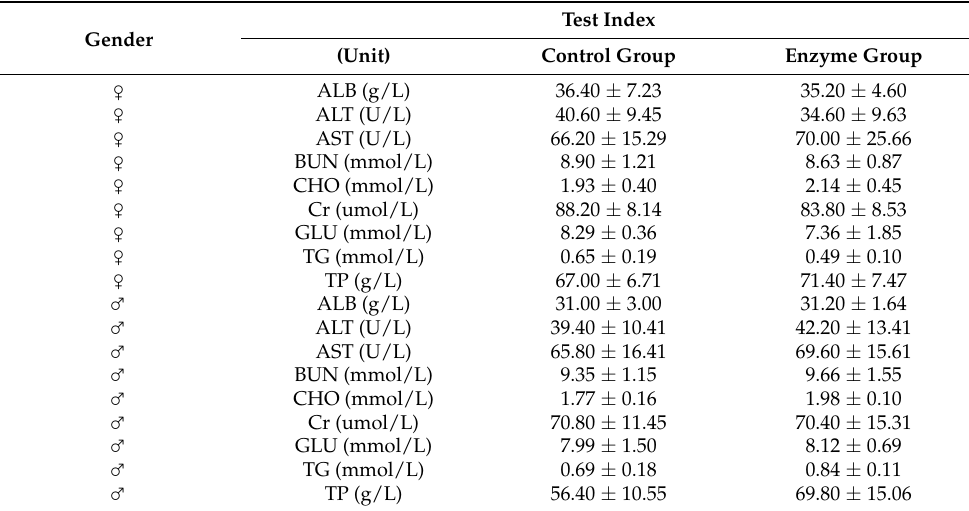
Table 4. Effects of test substance on blood biochemical indexes of rats ( n =